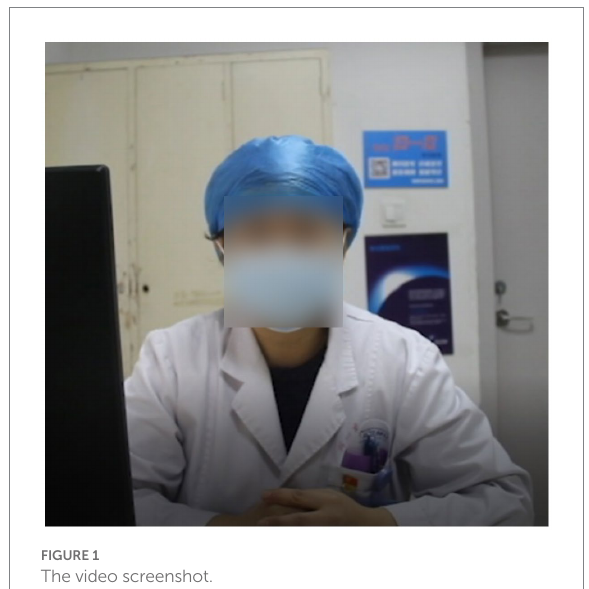
FIGURE 1 The video screenshot.